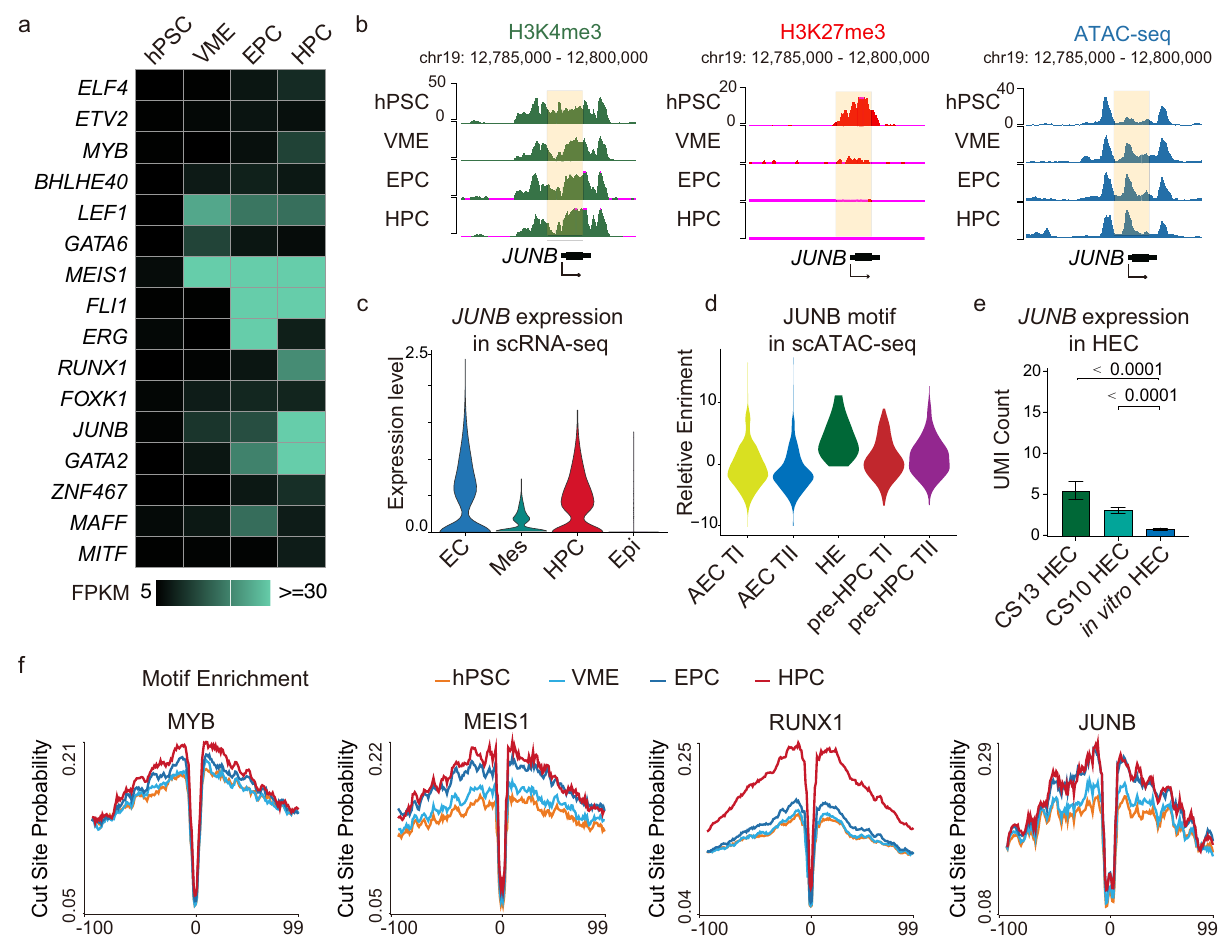
Fig. 6 Epigenetic pro fi ling identi fi ed JUNB as a potential regulator of hematopoietic speci fi cation. a Heatmap showing expression levels (FPKM) of bivalent TFs whose binding motifs are enriched in categories II and III in Fig.2g. The color gradient represents gene expression value. b The UCSC genome browser snapshots showing the signal of H3K4me3, H3K27me3, and ATAC-seq peaks at the putative promoter of JUNB , and the putative promoters are shaded. c Violin plots showing JUNB expression is higher in EC and HPC clusters in the scRNA-seq map in Fig. 4b. d Motif enrichment of JUNB in the AEC TI, AEC TII, pre-HPC TI, pre-HPC TII, and HE populations. e Bar plot showing the JUNB expression levels in CS10 HEC ( n = 124), CS13 HEC ( n = 21), and in vitro HEC ( n = 119). Data are presented as mean values± SEM. p values, two-tailed unpaired Student ’ s t test. f Visualization of the ATAC-seq footprint for MYB, MEIS1, RUNX1, and JUNB motifs during HPC differentiation. ATAC-seq signals across all these motif binding sites in the genome were aligned on the motif and averaged. hPSC human pluripotent stem cell, VME vascular mesoderm cell, EPC endothelial progenitor cell, HPC hematopoietic progenitor cell, Epi epithelial cell, Mes mesoderm cell, EC endothelial cell, HE hemogenic endothelium, AEC arterial endothelial cell, AEC TI AEC-type I, AEC TII